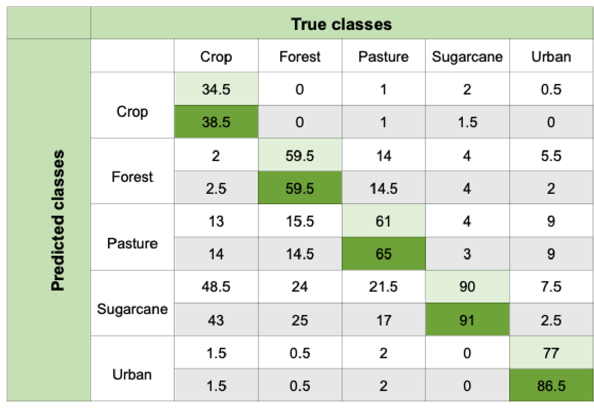
Figure 7. Producer ( top ) and user ( bottom ) accuracy achieved by the SVM classification for different sampling schemes and feature configurations.